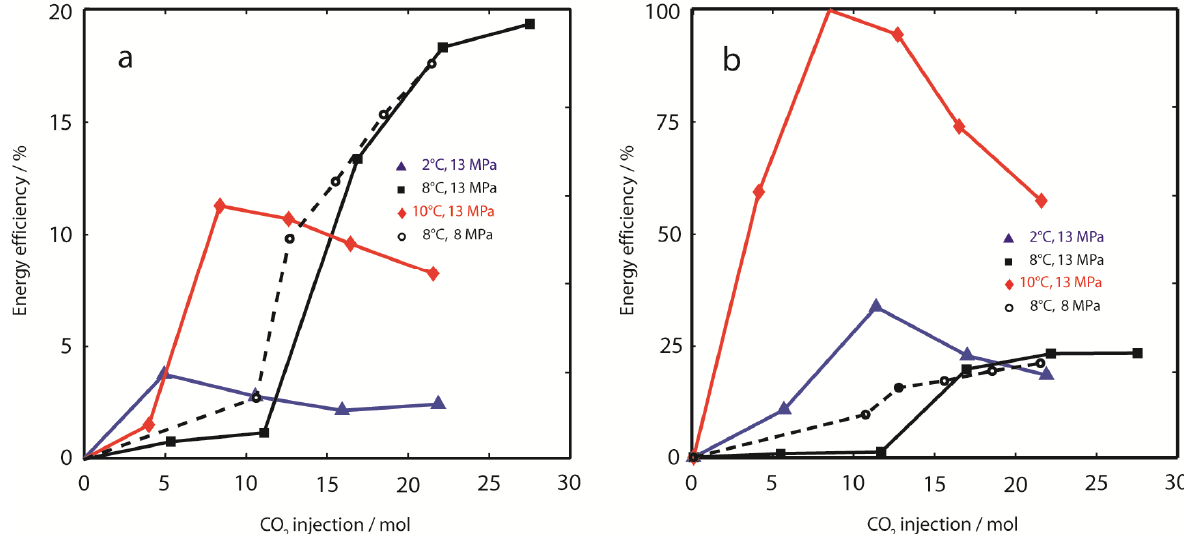
Figure 8. Energy efficiency. ( a ) Cumulative energy efficiency of gas production ( E